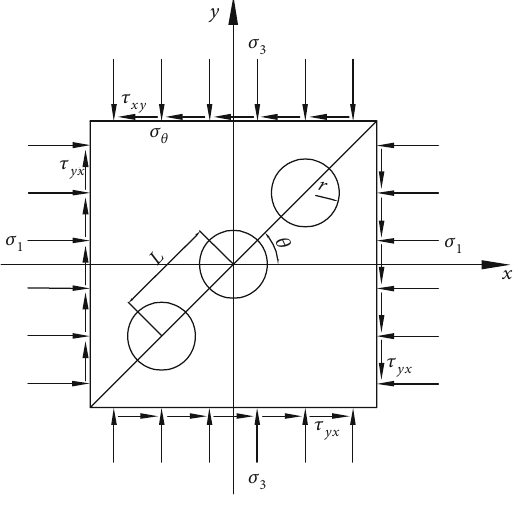
Figure 8: Distribution of